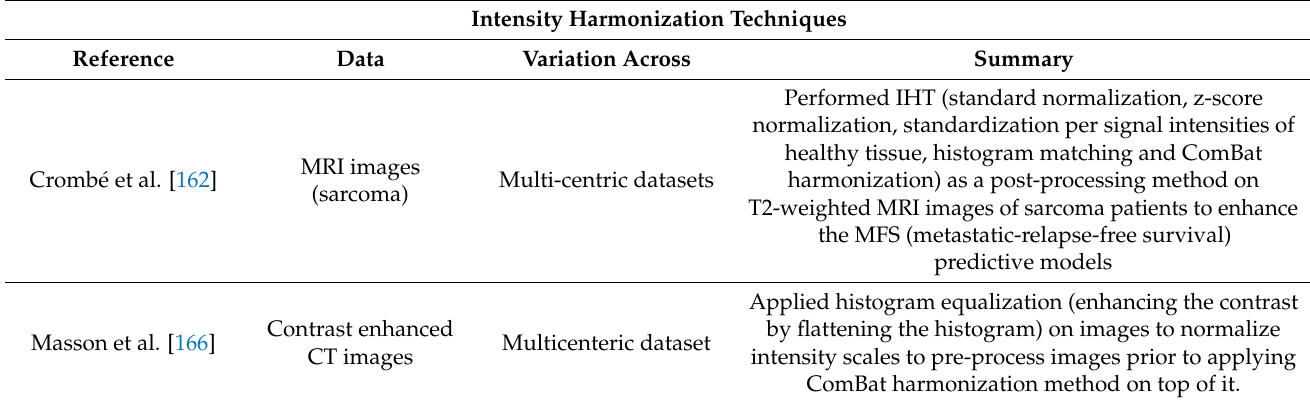
Table 7. Summary table of intensity harmonization